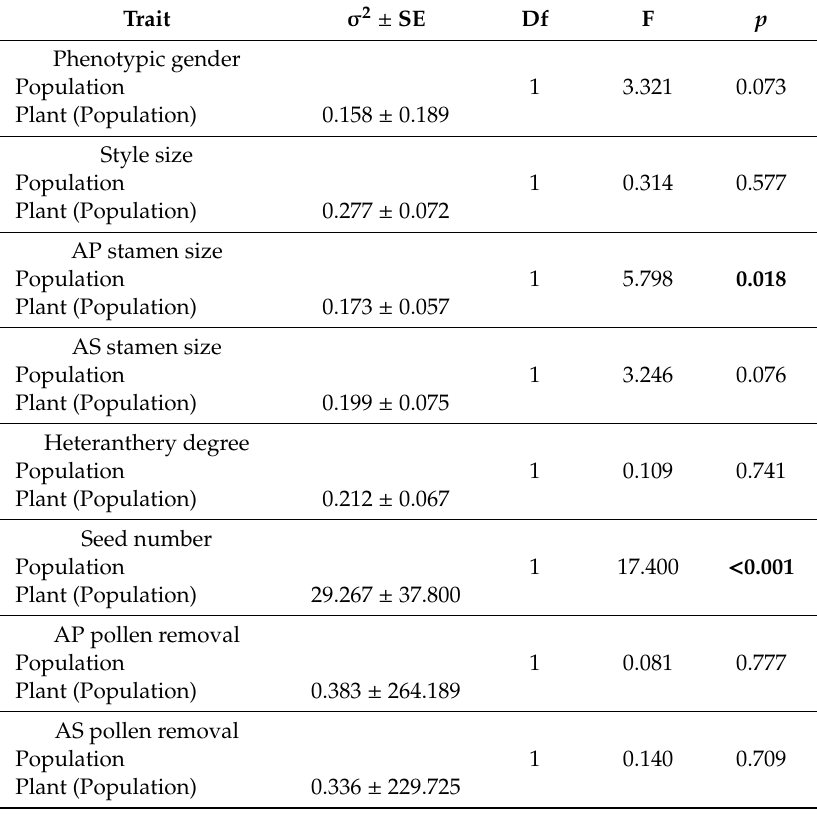
Table 1. Summary table of the Generalized Linear Mixed Models (GLMMs) used for the studied floral traits between populations and plants (random factor nested within populations). Phenotypic gender, style size, AP and AS stamen size, heteranthery degree, and AP and AS pollen removal were modeled as a quasi-Poisson error distribution. Seed number was modeled as a Gaussian error distribution. AP means antepetalous and AS means antesepalous. Sample size was taken from three flowers of 35 individuals in the Uberl â ndia (UDI) population (N = 105) and 37 individuals in the Delfin ó polis (DEL) population (N = 117). Significant p -values are